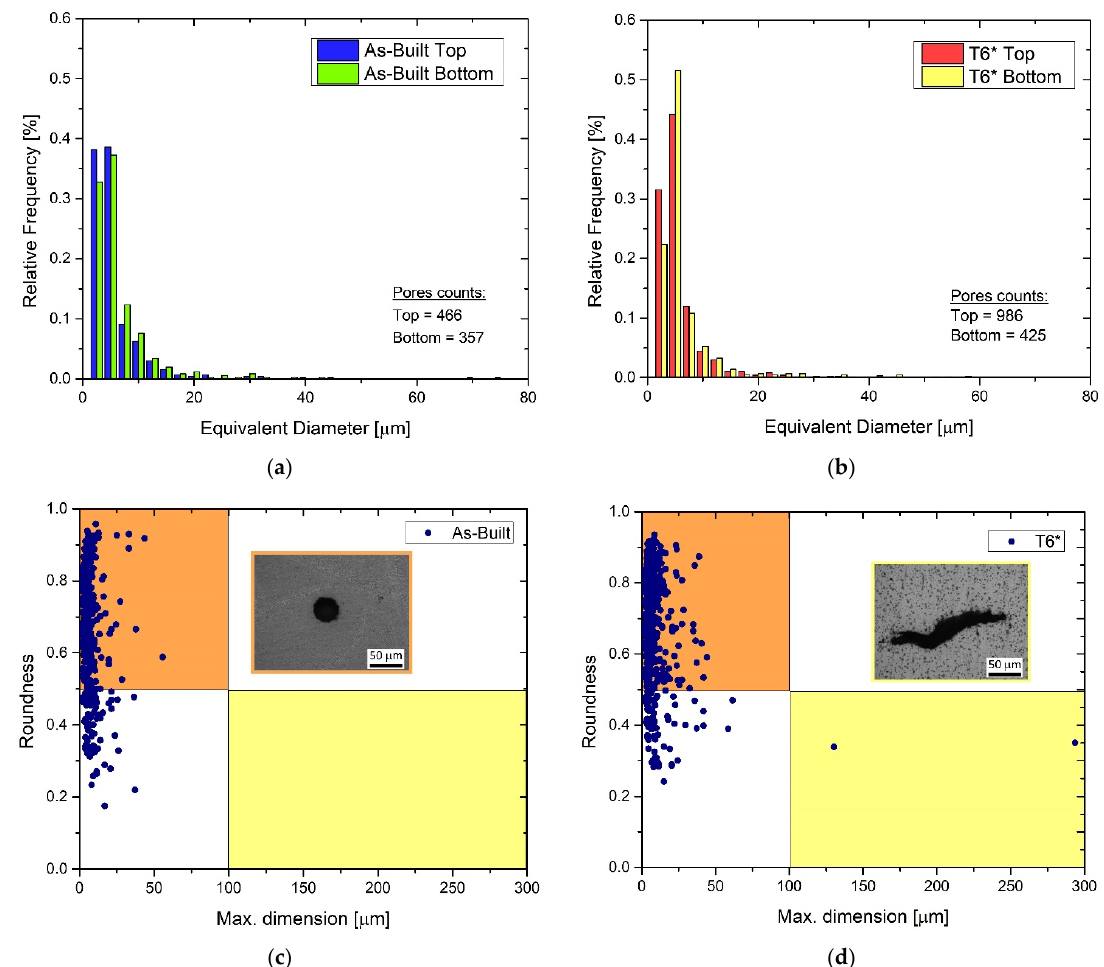
Figure 5. ( a , b ) Statistical distribution of the equivalent diameter of the pores and ( c , d ) their roundness versus their maximum dimensions in: as ‐ built ( a , c ) and heat ‐ treated T6* samples ( b , d ).